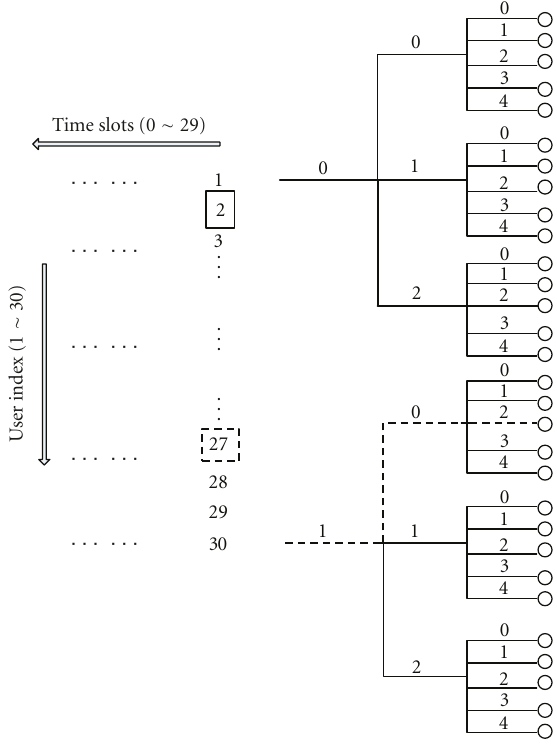
Figure 3: One example of RNS-assisted multistage hopping